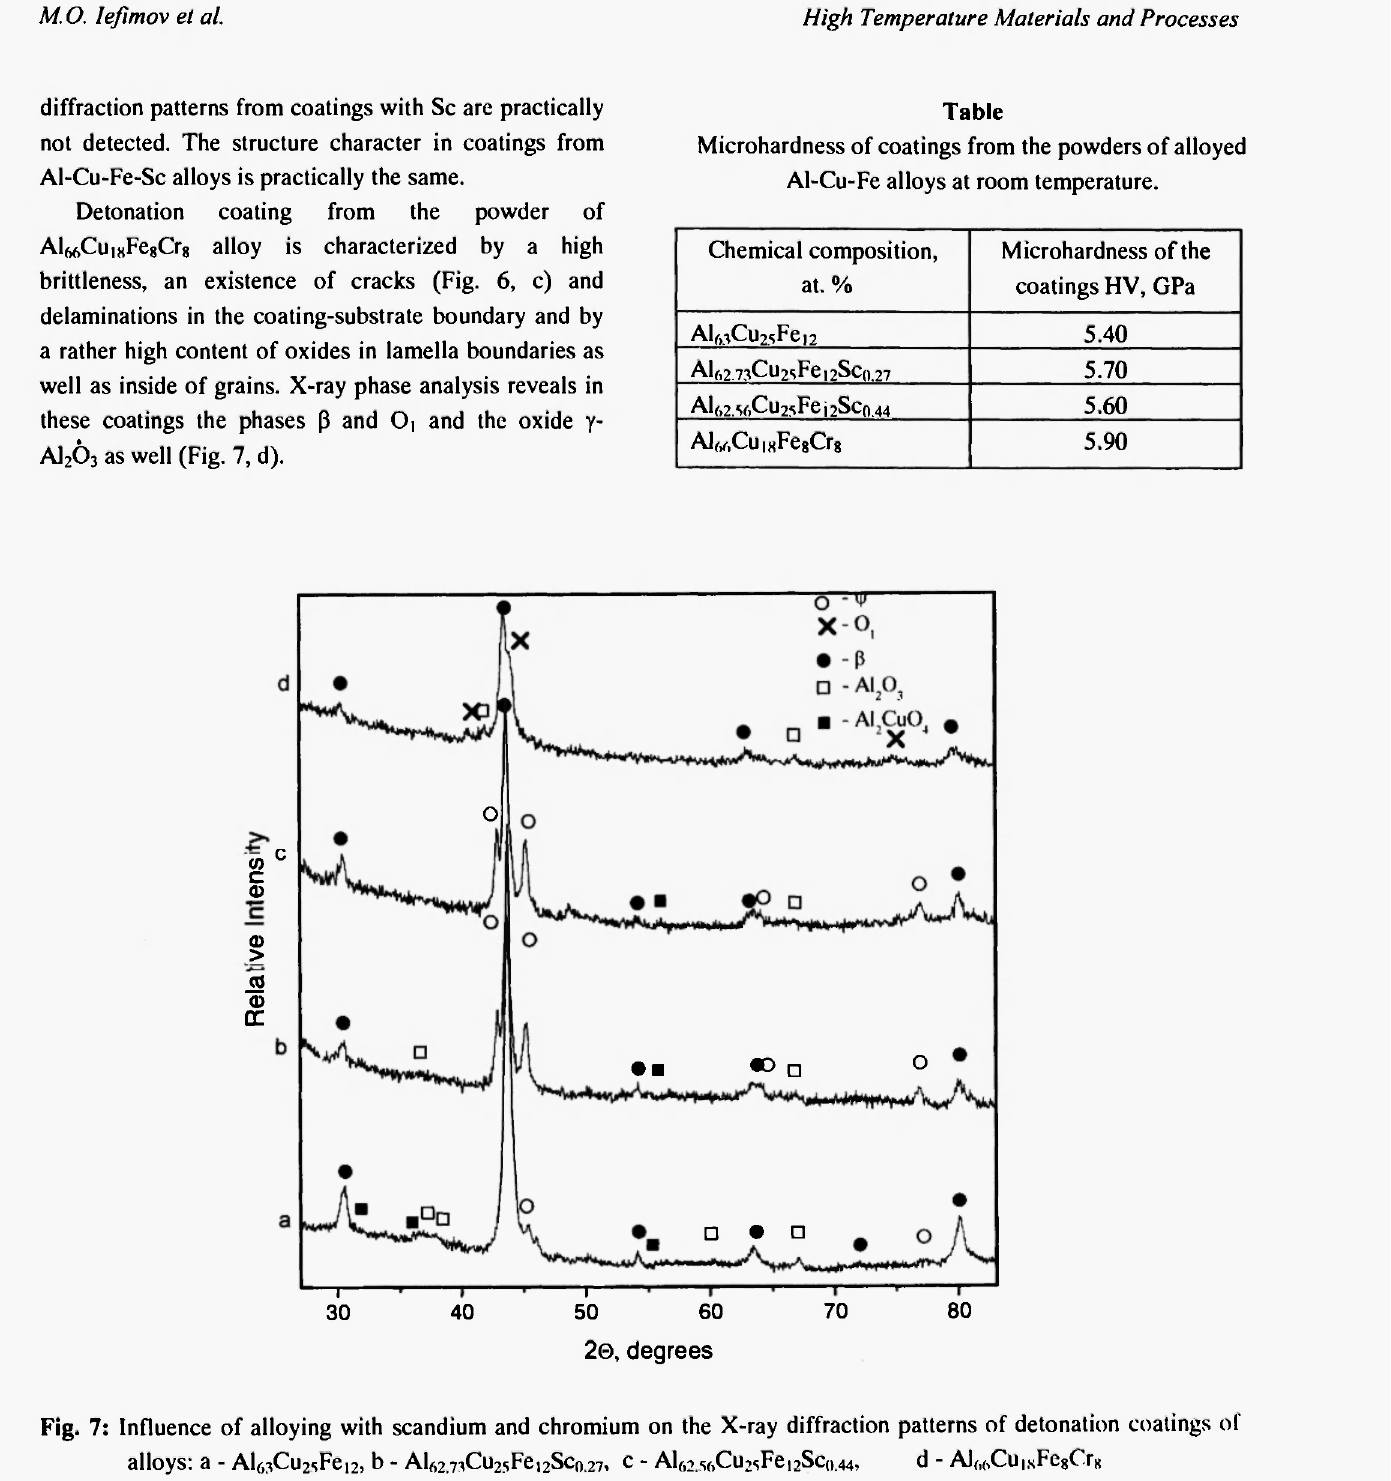
Fig. 7: Influence of alloying with scandium and chromium on the X-ray diffraction patterns of detonation coatings of alloys: a - Al M Cu 2 sFe 12 , b - Al f)2 7 1 Cu2_sFe 12 SCf ) .27 1 c - Al 62 S( ,Cu 2 sFe| 2 SC(| 4 4